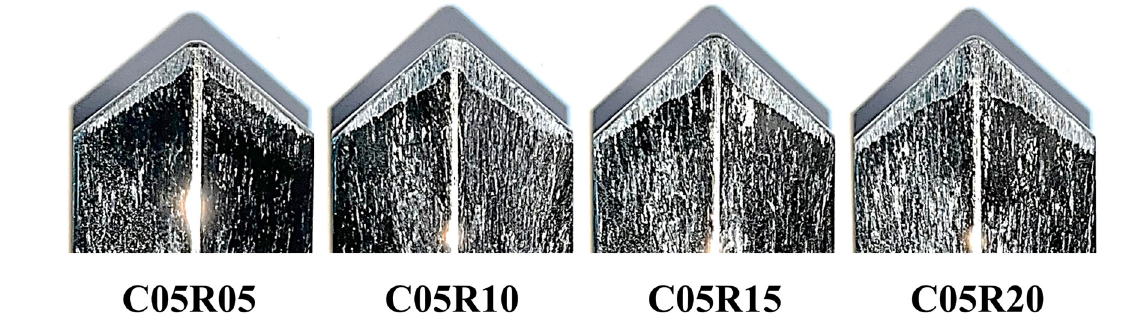
Figure 13. Friction surface of the cutting tool after the cutting test. Table 4. Mean and peak cutting forces for various rake angles.